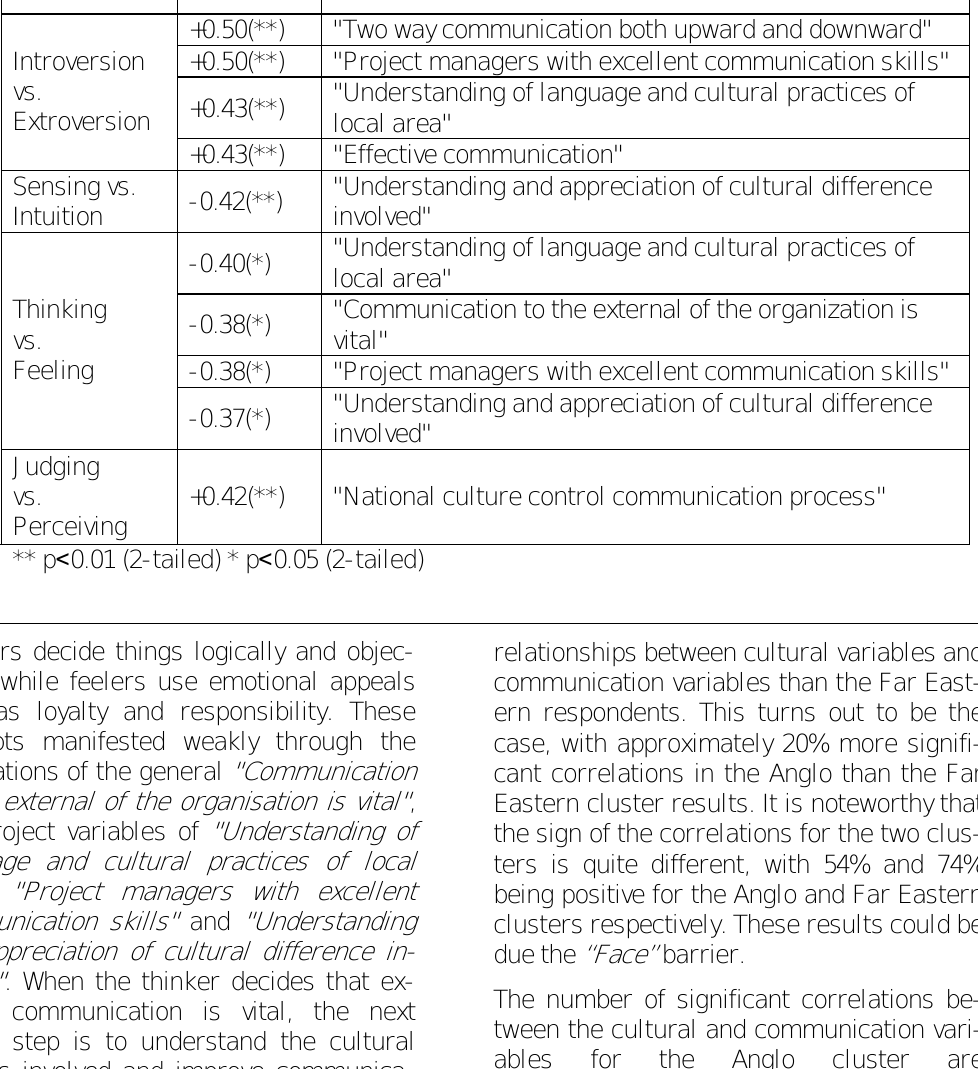
Table 4: Correlation between Personal Characteristics and Communication